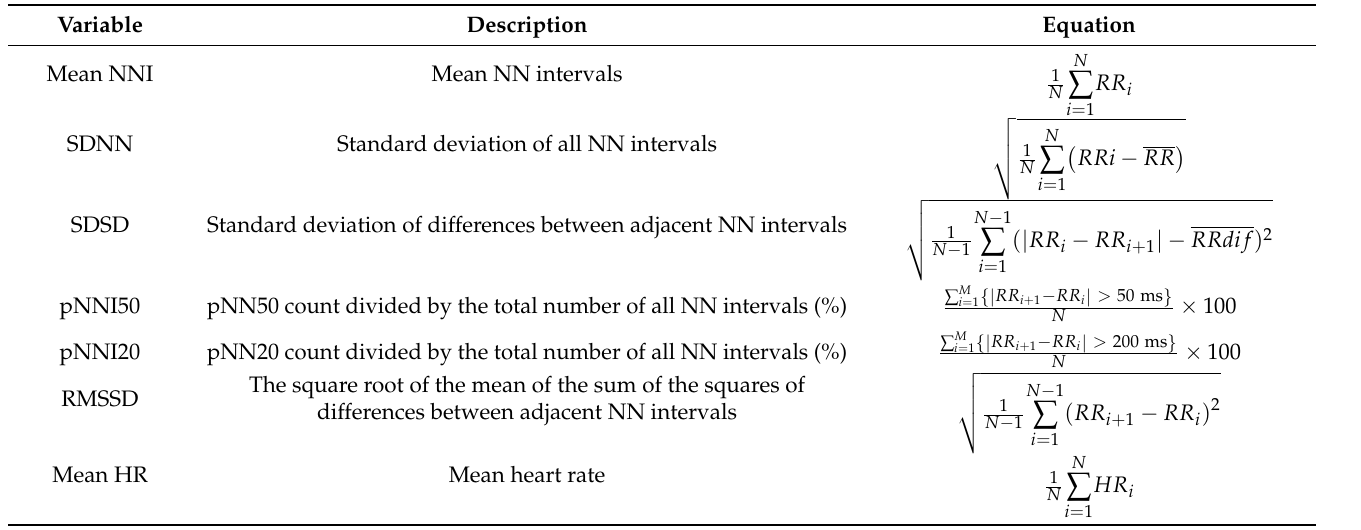
Table 1. Time-domain variables for heart rate variability [38].